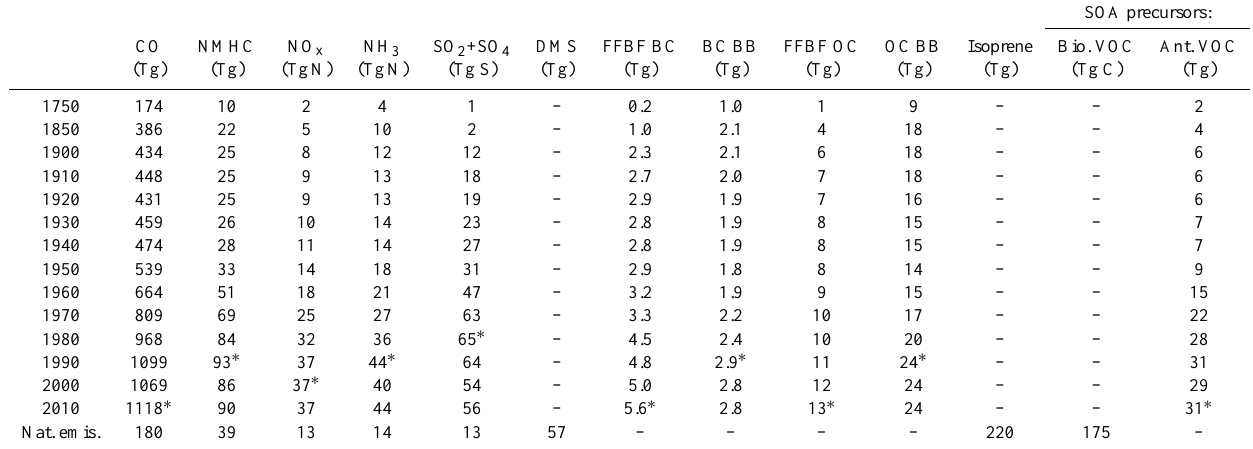
Table 1. Emissions used in this study. For each year and component the annual total anthropogenic and biomass burning emissions are listed. The natural emissions are presented in the bottom line. The year with maximum emissions are marked with a star ( ∗